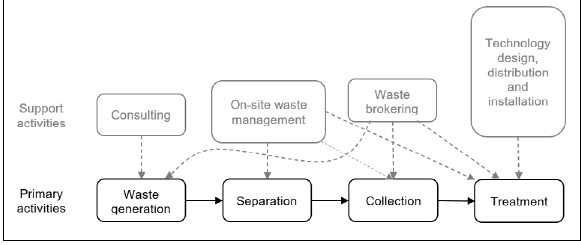
The organic waste treatment value chain, depicting both primary and support